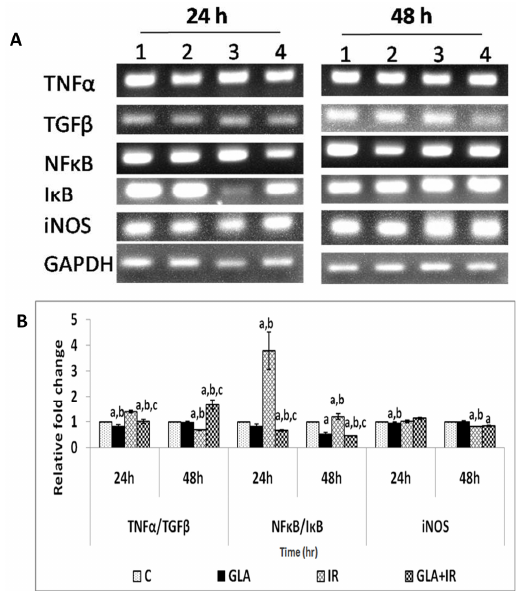
Figure 7. Effect of GLA and IR on genes regulating the inflammatory pathway (TNF, TGF, NF-kB, IkB, iNOS) in RAW 264.7 cells at 24 and 48 h post-irradiation ( A , B ). Values (n = 3) expressed as mean ± SEM. a , b , c Significant ( p < 0.01) when compared with control, GLA, and irradiation, respectively. 1, C; 2, GLA; 3, IR; and 4, GLA + IR. C, control; GLA, gamma-linolenic acid; IR, irradiation (2 Gy). Biomolecules 2022 , 12 , x FOR PEER REVIEW Apoptotic pathway: The Bcl-2/Bax ratio was significantly ( p < 0.01) increased in GLA + IR compared with IR at both 24 and 48 h post-radiation, whereas IR induced a significant ( p < 0.01) decrease in Bcl-2/Bax ratio compared with I control (C). In a similar fashion, radiation (IR) caused a significant ( p < 0.01) increase in Cas-1 and Cas-3 expressions com- pared with I control (C) at both time points, which reverted to normal upon GLA pre- treatment (GLA + IR). p53 expression was significantly ( p < 0.01) increased in IR compared to I control (C), which was significantly ( p < 0.01) lower in GLA + IR-treated cells at 24 h; however, it (p53) reverted to normal at 48 h in both the groups. AIM-2 levels were signif- icantly ( p < 0.01) high in GLA + IR-treated cells compared with IR cells at 24 h, though its expression showed a significant decrease ( p < 0.05) at 48 h (Figure 8).